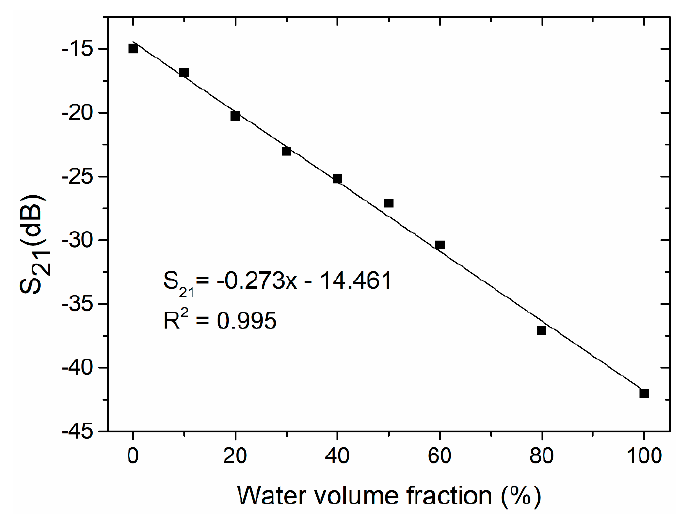
Figure 16. Transmission coefficient as a function of the water volume fraction in the water/ethanol mixture.